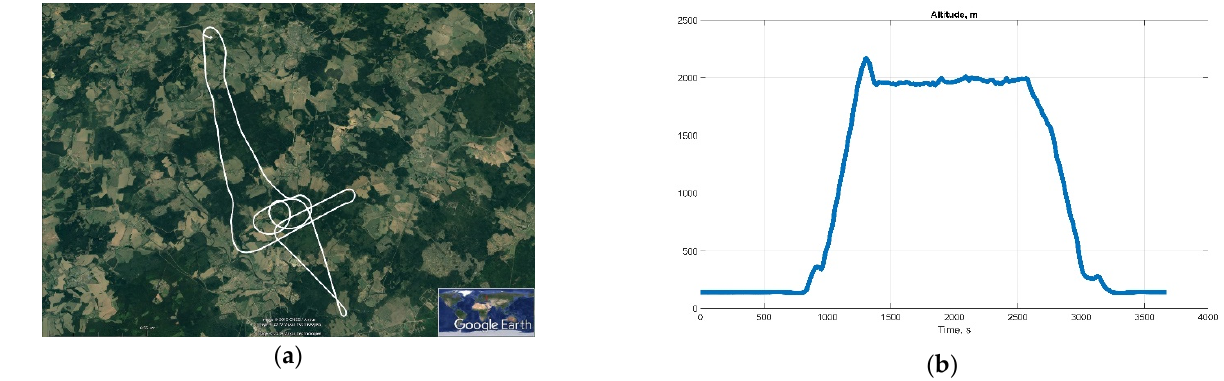
Figure 14. Helicopter test track: ( a ) horizontal track; and ( b ) altitude.